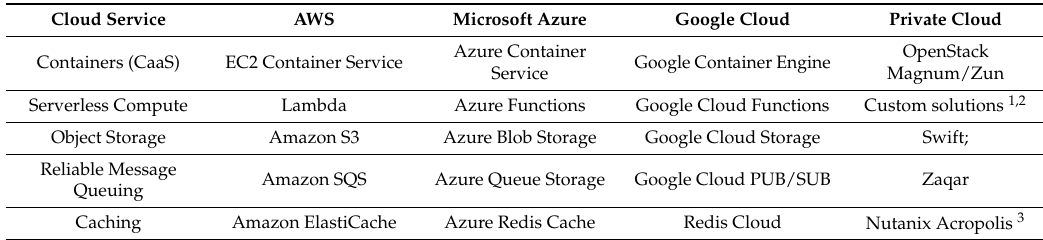
Table 2. Additional Useful Cloud Services for